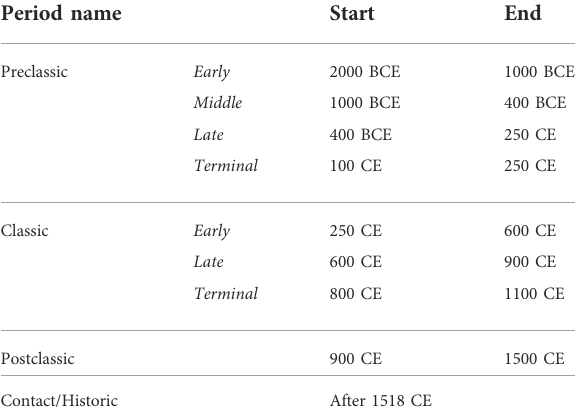
TABLE 1 Prehistoric and historic cultural periods of the lowland Maya region of Mesoamerica (cultural period information adapted from Demarest (2004) and Sharer and Traxler